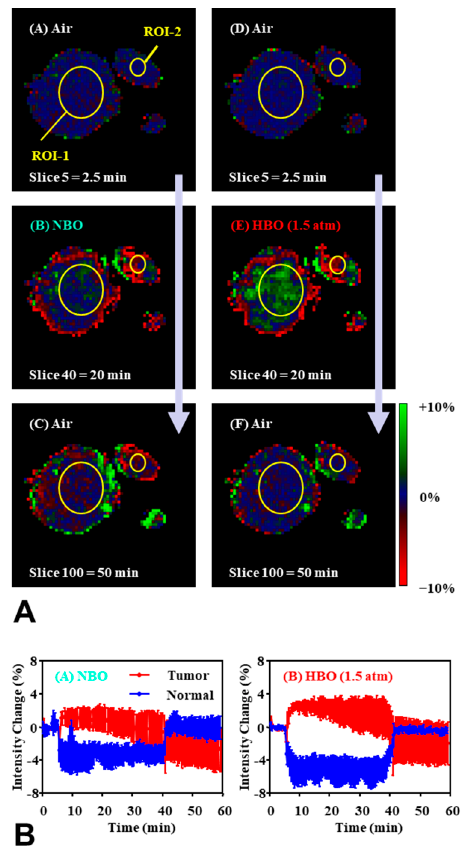
Figure 8. An example of TOLD MRI. ( A ) Comparison of T 1 weighted MR images of SCC tumor bearing and normal leg of an identical mouse under (left column) normobaric and (right column) hyperbaric oxygen challenges. A mouse legs was scanned by GEFI sequence, and axial 2 mm slice reconstructed on 64 × 64 matrix was obtained every 30 sec for 60 min. The gas condition was switched from air to normobaric or hyperbaric oxygen 5 min after starting scan, kept for 35 min, and then switched back to air. The normobaric and hyperbaric experiments were sequenced with 20 min gap. Percent-changes of T 1 -weighted image intensities from baseline images were observed. No signals are observed under air flow (top panels). Positive and negative signals are observed in the center and periphery of tumor leg, respectively, under the tasks (center panels). Signals observed in center of tumor dropped down to base line level when breathing gas was switched back to air (bottom panels). ( B ) Time course of T 1 -weighted signal changes in tumor (ROI-1) and normal (ROI-2) legs under normobaric (left) and hyperbaric (right) challenges. The values indicated the average ± SD of results of 4 mice. The figures were partly modified from our previous reports [79].